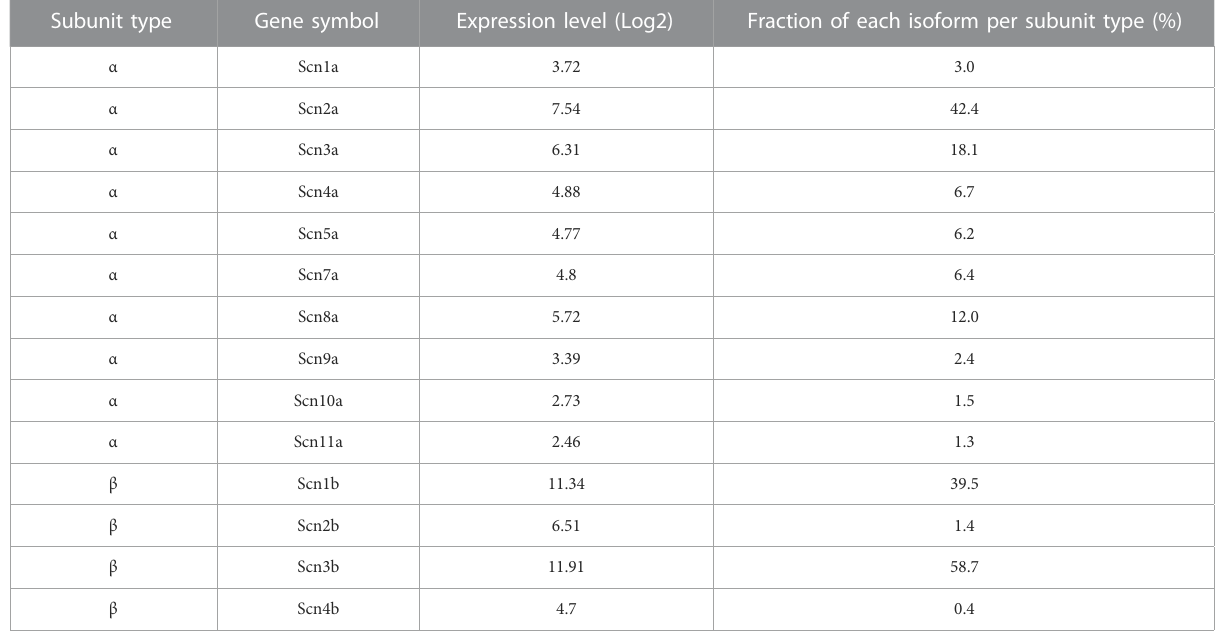
TABLE 1 Relative expression levels of VGSC subunit isoforms in neocortical cultures. Subunit type Gene